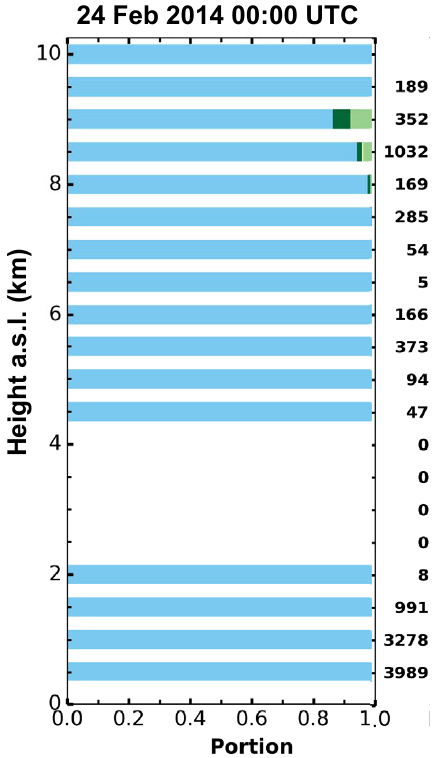
Figure 7. Relative residence time of the air masses over ground within the 10 days prior to their arrival over Barbados (24 Febru- ary 2014, 00:00UTC). For each height level (500m) an ensemble of 27 HYSPLIT trajectories was calculated. The numbers on the right-hand side indicate the total amount of hours that the ensemble of 10-day backward trajectories at each height level spend close to the ground (below 2km height) and could be possibly laden with aerosols. The color bar indicates the portion of different surface ar- eas, where blue stands for ocean and green for different types of continental land cover (forest, grass, etc.). The land cover is taken from MODIS. Between 2.5 and 4.0km height, the trajectories did not come close to the ground. The air masses in the MAL (up to 2km height) are purely marine. The same result was found on 25 February 2014, 00:00UTC (not shown).